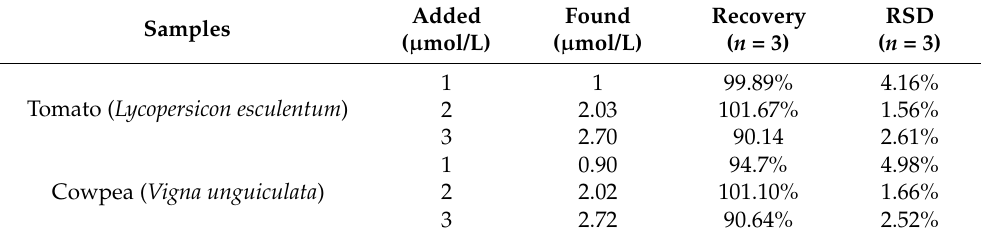
Table 3. Results of actual sample recovery.